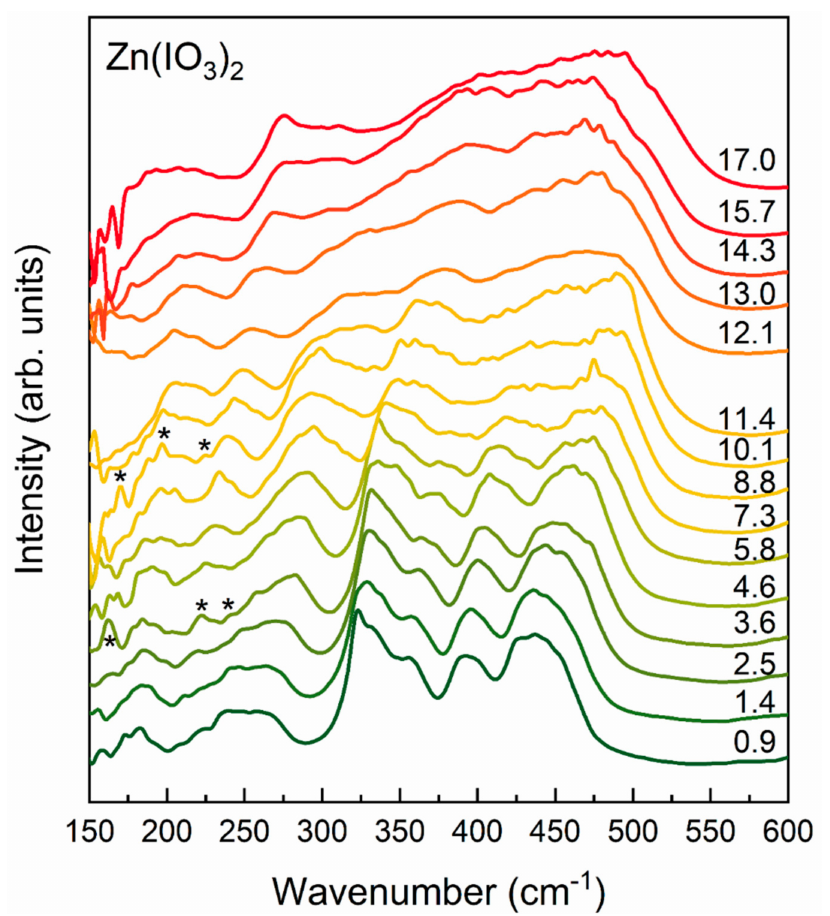
Figure 3. IR spectra acquired at increasing pressures (indicated in GPa in the figure). The asterisks indicate changes in the phonons described in the